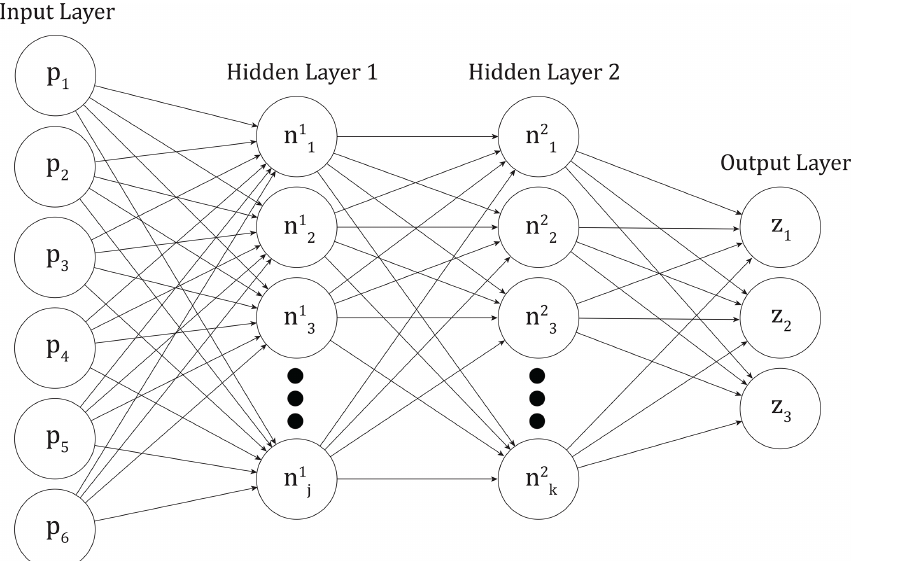
Figure 2. Representative neural network architecture, with input values as land model parameters p i , three output values z m , and two hidden layers with j and k nodes,